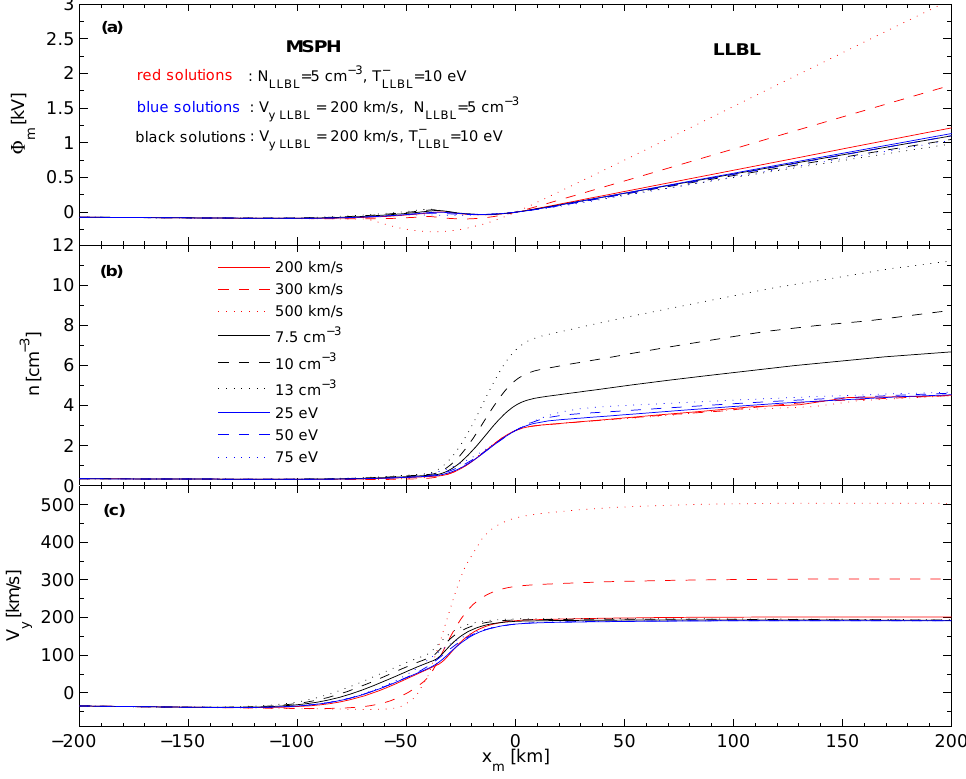
Fig. 2. Vlasov equilibrium solutions describing the magnetospheric generator. The panels show: (a) the magnetospheric potential, 8 m ; (b) the plasma density, n ; (c) plasma bulk velocity in the antinsunward direction, V y (see also Fig. 1a–b). The magnetic field in x m L , at the left (MSPH) side of the TD, is equal to B zm = 30nT. Each color corresponds to solutions obtained by changing one of the following asymptotic parameters at the right hand-side: LLBL bulk velocity (red), LLBL density (black), LLBL electron temperature (blue). Different linestyles illustrate solutions obtained for different values of the same asymptotic parameter, see legend of panel (b). When one parameter is = 10eV (see also text inserted in panel a). The asymptotic varied the others take constant values: V LLBL = 200km/s, n LLBL = 5cm − 3 , T − LLBL parameters at the left hand-side (MSPH) are constant and given in Table 1. The integration is carried out between x m L =− 10000km and x m R = 5000km but only the central part of the solutions ( − 200km <x m < + 200km) is shown in order to better visualize differences between the different